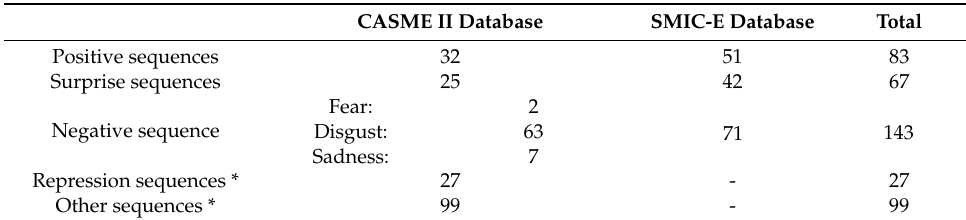
Table 2. Distribution of the ME types in the CASME-II and SMIC-E